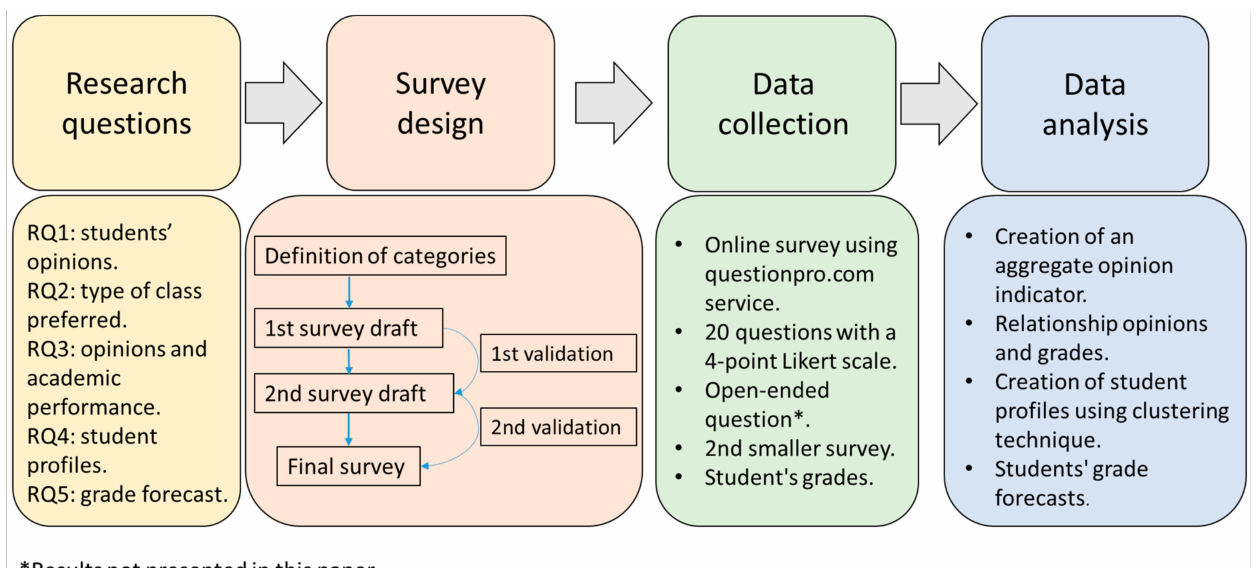
Figure 1. Schematic methodology used in the research.